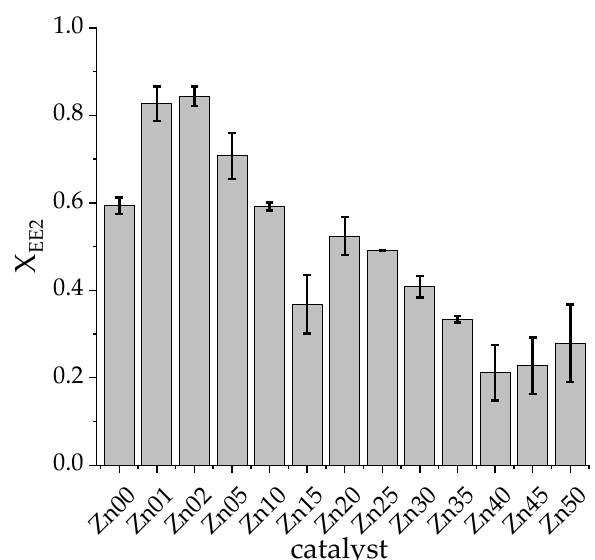
Figure 2. Catalyst screening of titanium dioxide-based photocatalysts, doped with different amounts of zinc synthesised by a sol-gel method; the number in the catalyst’s name (Zn25) indicates the amount of zinc in comparison to the amount of titanium used for synthesis in mol-percent; Zn00 resembles pure TiO 2 ; conversion of EE2 X EE2 was studied; double determination; irradiation time = 3.5 min.